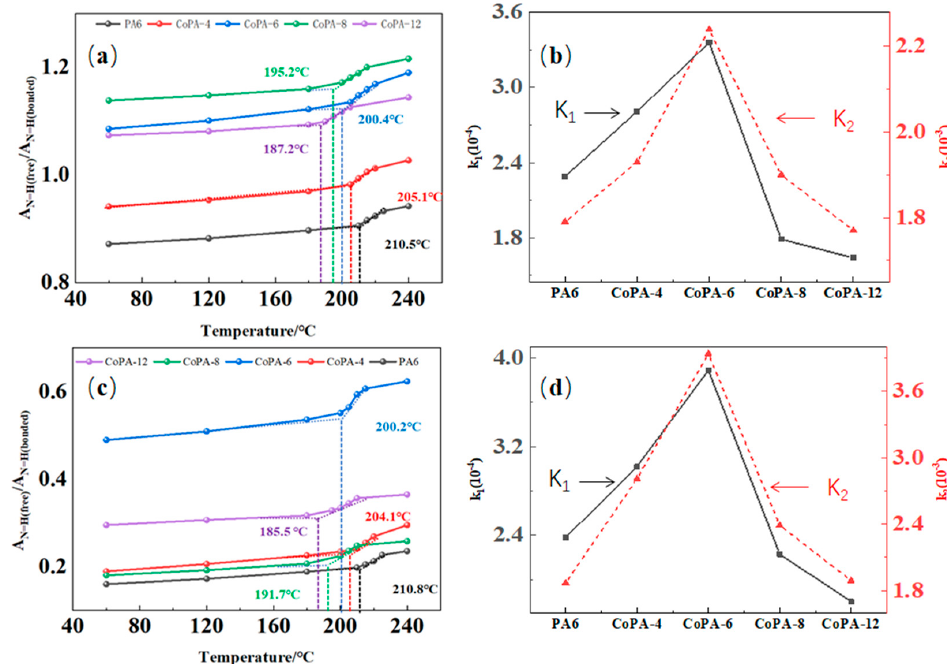
Figure 8. The temperature dependence of the fraction ratio of ordered hydrogen and free N–H bending vibration bonds (amide II mode) (1539 cm − 1 ) ( a ) and the hydrogen-bonded N–H stretching bond (3294 cm − 1 ) ( c ) of PA6 and CoPA AS fibers calculated according to the area of fitted-peak free bond and bonded N-H groups, and the linear fit coefficients of the fraction ratio change tendency of amide II mode ( b ) and the hydrogen-bonded N-H stretching bond ( d ) before (K1) and after (K2) inflection points in curves of A]N-H-free /ANH-bonded versus reciprocal temperature. The total area changes of the N-H stretching region are induced not only by heat, but also by the tendency of hydrogen bonds between molecular chains, which are influenced